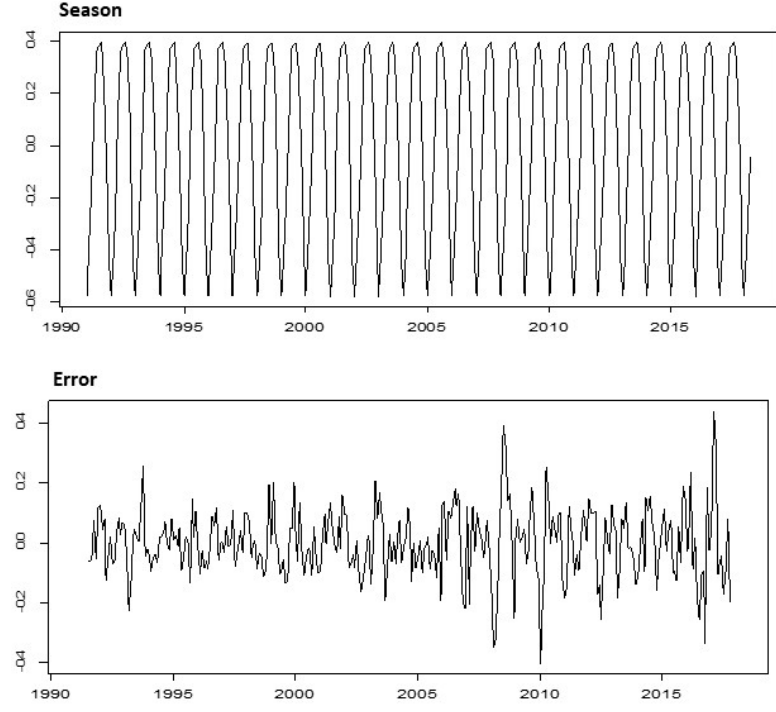
Figure 3. The additive decomposition of cents/kWh illustrates the significant trend and seasonal components of the time series.